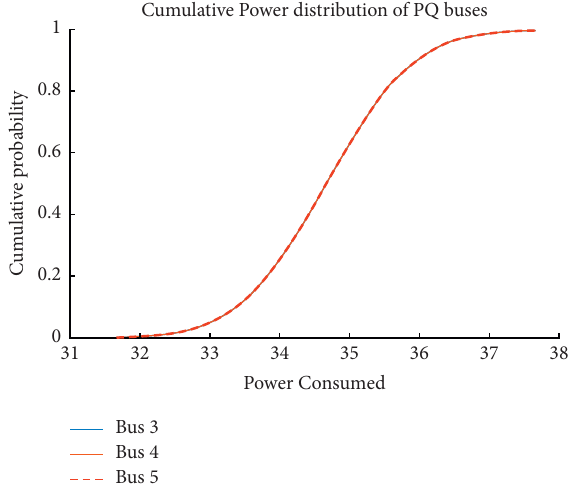
Figure 14: Cumulative power distribution at buses 1, 2, 3, 6, and 8.